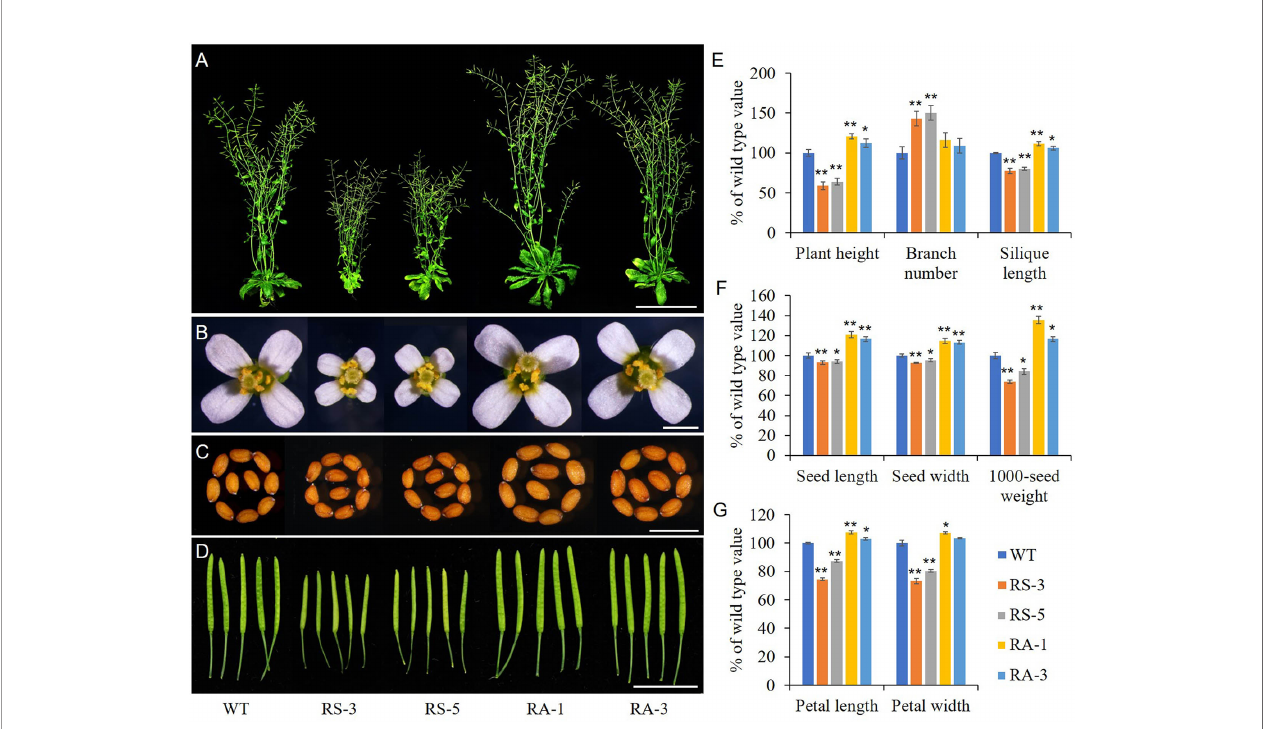
FIGURE 3 | Morphological analysis of the homozygous transgenic lines and wild type (WT). (A) Whole morphology. (B) Flowers. (C) Seeds. (D) Siliques. (E) Statistical analysis of plant height, branch number and silique length. (F) Statistical analysis of seed length, seed width and 1000-seed weight. (G) Statistical analysis of petal length and width. WT, wild type; RS-3 and RS-5, ZmRLK7 sense transgenic lines; RA-1 and RA-3, ZmRLK7 antisense transgenic lines. Values are means with SD relative to the respective wild-type values. * and ** denote signi fi cant differences at p < 0.05 and 0.01 by ANOVA, respectively. Bars = 10 cm for (A) , 0.5 mm for (B, C) and 1 cm for (D)